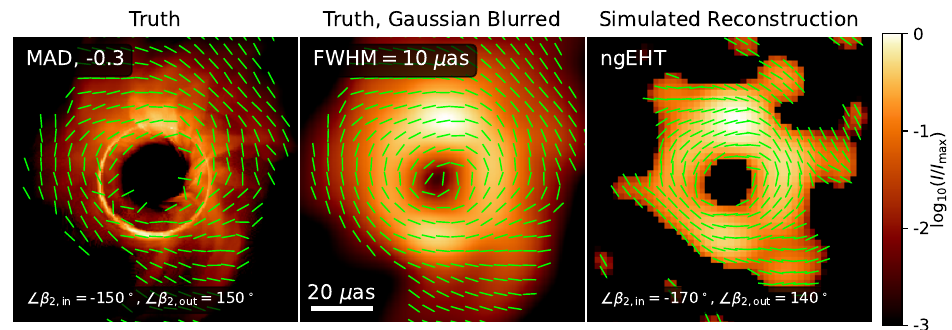
Figure 3. Example total intensity and linear polarization map of a model of M87* that exhibits direct signatures of frame dragging, adapted from Ricarte et al. [62]. Inflowing streams approaching the horizon must turn around due to the existence of an ergosphere in the Kerr space-time, leading to characteristic “S”-shaped streams and flips in the sign of ∠ β 2 as a function of radius. The central panel shows the same simulation blurred with a Gaussian with a full-width at half-maximum of 10 micro-arcseconds, which resembles the spatial resolution obtained when simulating the image reconstruction process. The right-most panel shows a simulated image reconstruction using the phase I ngEHT. Although the spatial resolution is not sufficient to observe the turnaround of individual streams, the ngEHT can observe the flip in the sign of ∠ β 2 as a function of